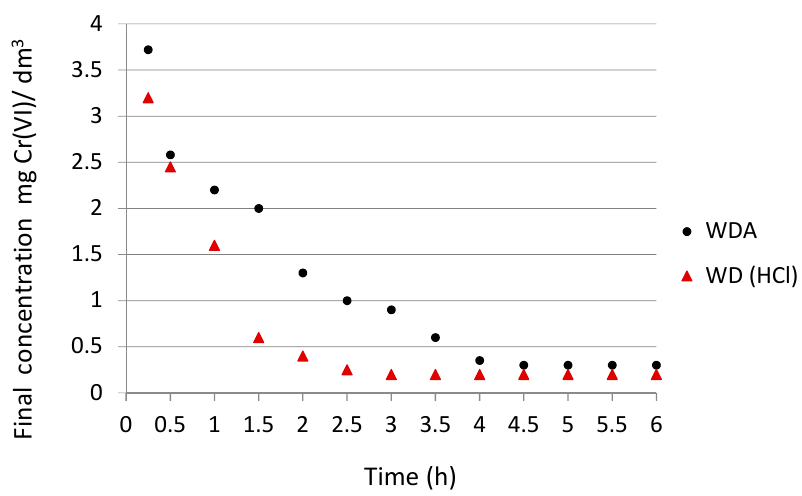
Figure 3. Chromium (VI) final concentration in solution at pH 2.